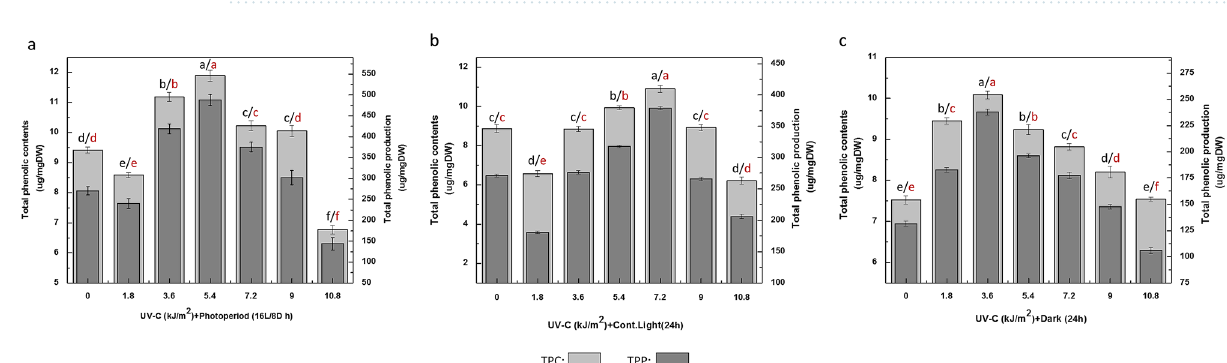
Figure 3. ( a ) Determination of Phenolic Contents in callus cultures of Fagonia indica elicited with various treatments (0–10.8 kJ/m 2 ) UV-C radiations and grown in Photoperiod (16L/8D h). ( b ) Determination of Phenolic Contents in callus cultures of Fagonia indica elicited with various treatments (0–10.8 kJ/m 2 ) of UV-C radiationsand grown in contineous light (24 h). ( c ) Determination of phenolic contents in callus cultures of Fagonia indica elicited with various treatments (0–10.8 kJ/m 2 ) of UV-C radiationsand grown in complete darkness (24 h). Values represented as mean ± SE of three replicates. Different (black for TPC, red for TPP) letters represent significant differences between the various experimental conditions ( p <